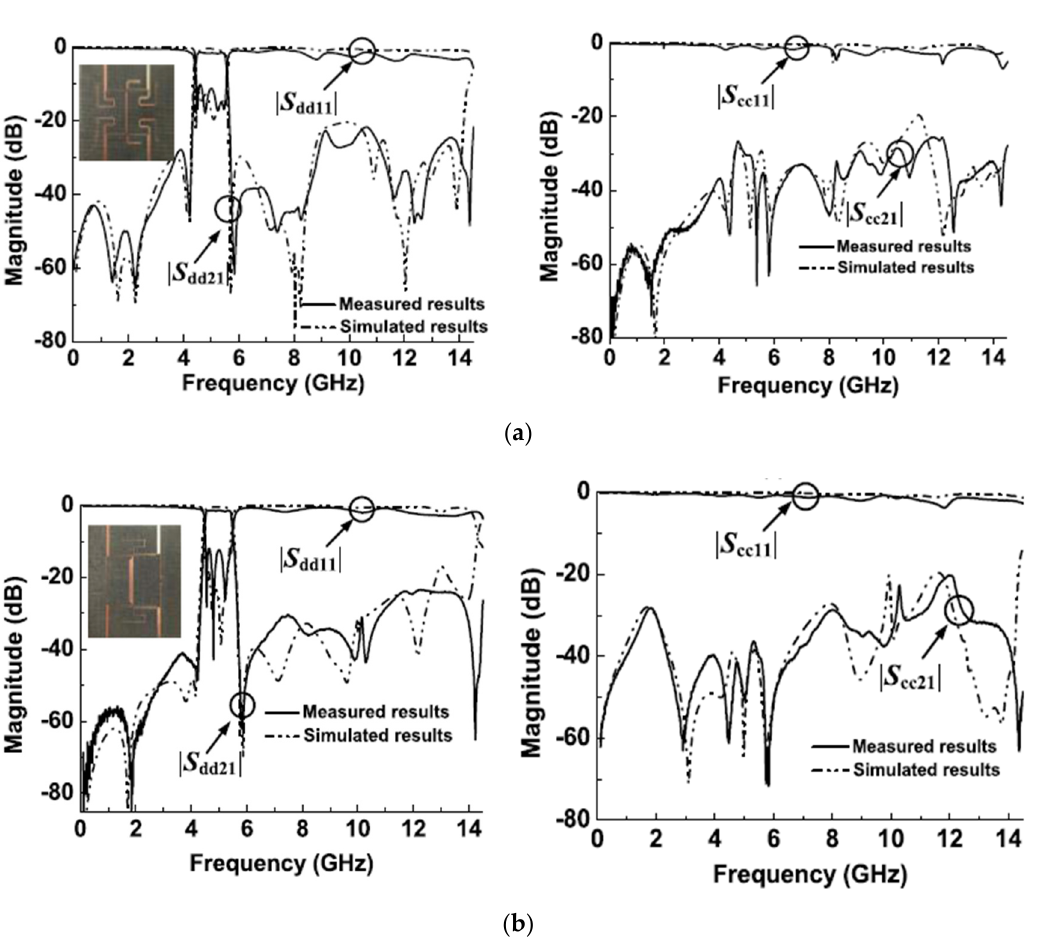
Figure 18. Photographs for the prototypes and s-parameter results of proposed balanced wide-band BPFs [87]: ( a ) Firat design; ( b ) Second